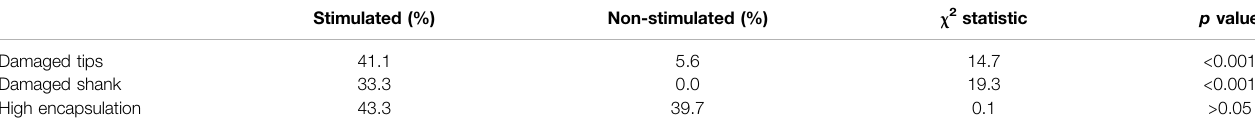
TABLE 4 | Effect of stimulation on material degradation and encapsulation for IrOx arrays. Non-stimulated tips were not electrically connected. Stimulated